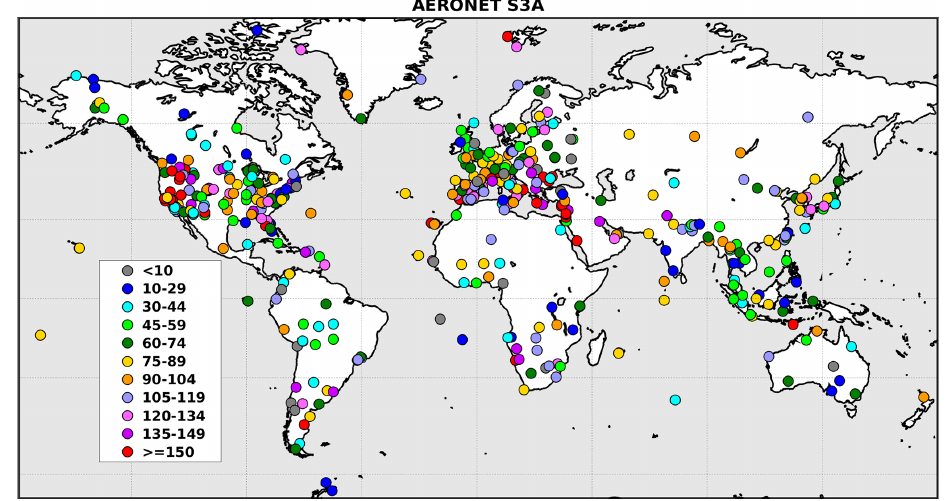
Figure 1. Location of the AERONET stations and number of matchups with S3A per station (see legend) for the period 14 January 2020 to 30 September